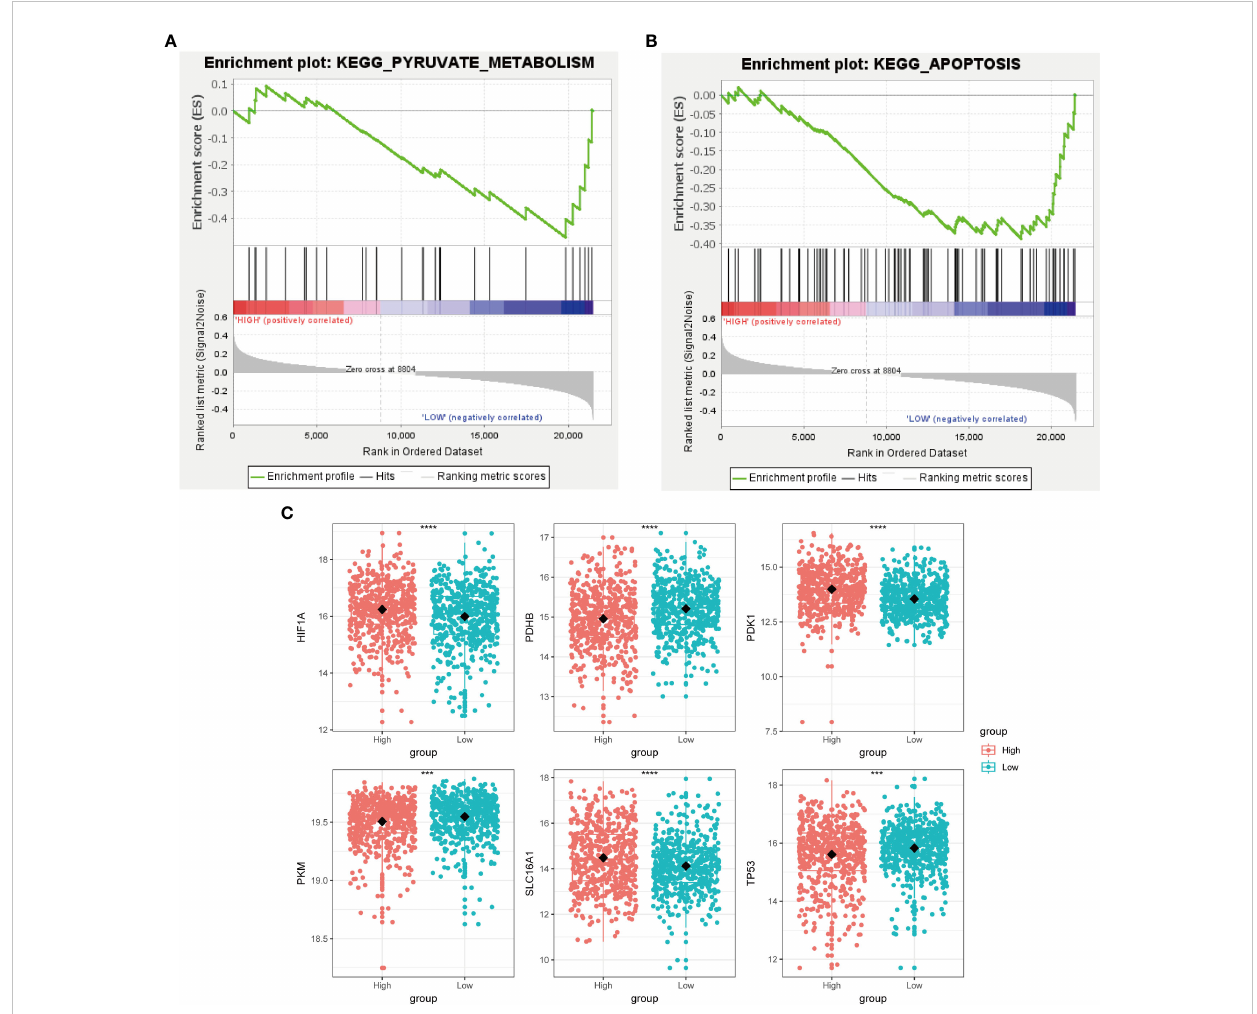
FIGURE 6 Metabolic characterization of breast cancer samples strati fi ed by the high- and low-scoring groups. GSEA enrichment plot of regulation of autophagy (A) and pyruvate metabolism (B) of the low-scoring group. (C) Boxplot showed that glycolysis-related genes, including HIF1A, PDHB, PDK1, PKM, SLC16A1, and TP53, had a differential expression pattern among the high- and low-scoring groups. ( ***p < 0.001, ****p< 0.0001